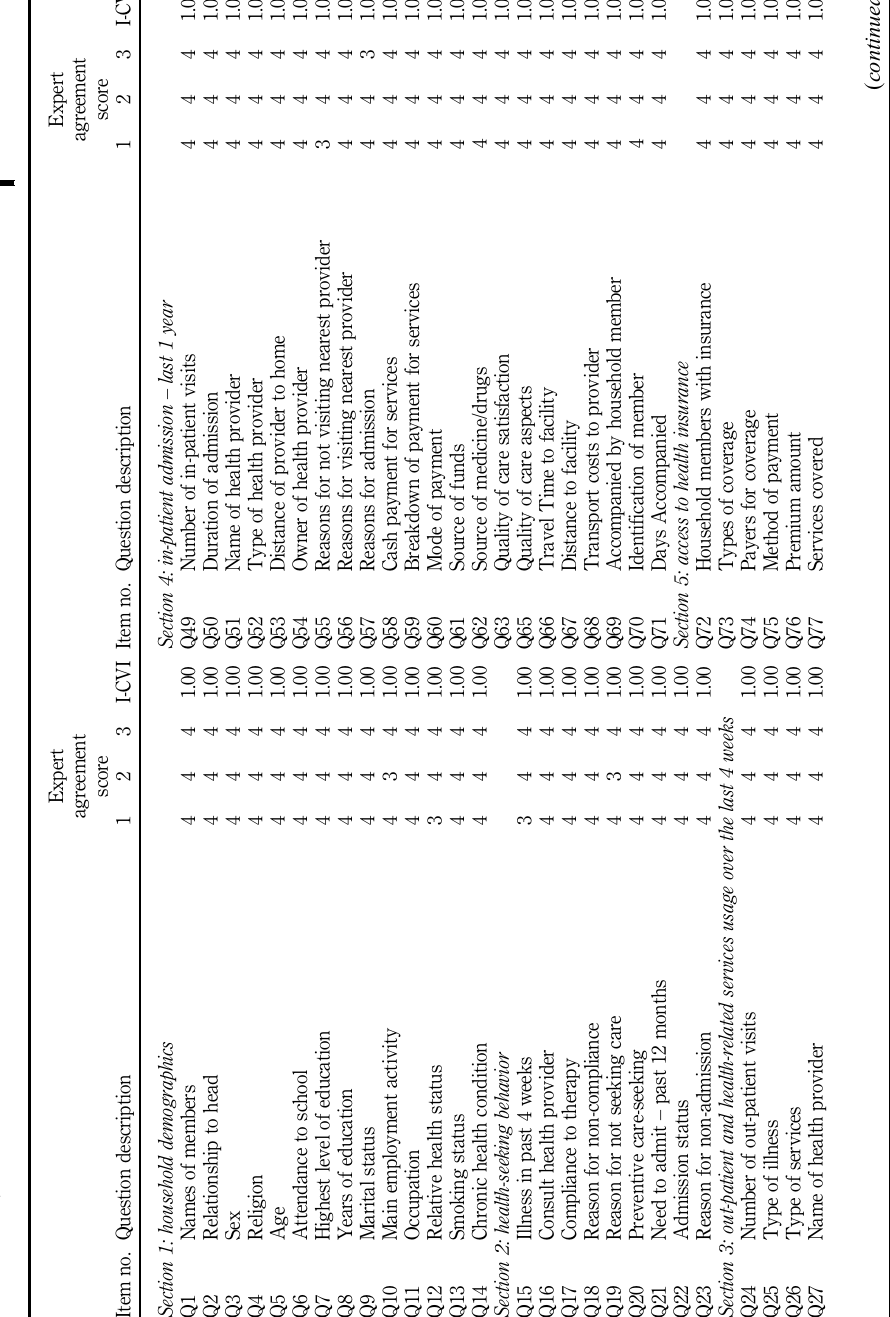
Table I. Content validation of household health expenditure questionnaire by content